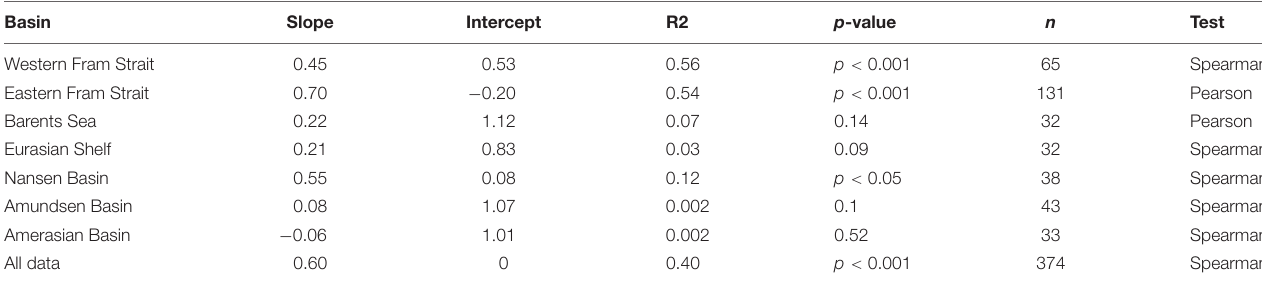
TABLE 2 | Log POC/Chla correlations of samples taken during 19 summer expeditions with RVs Polarstern , Maria S Merian and Lance to the Central Arctic Ocean and the Fram Strait including parts of the Greenland Sea between 1991 and 2015. Basin Slope Intercept R2 p